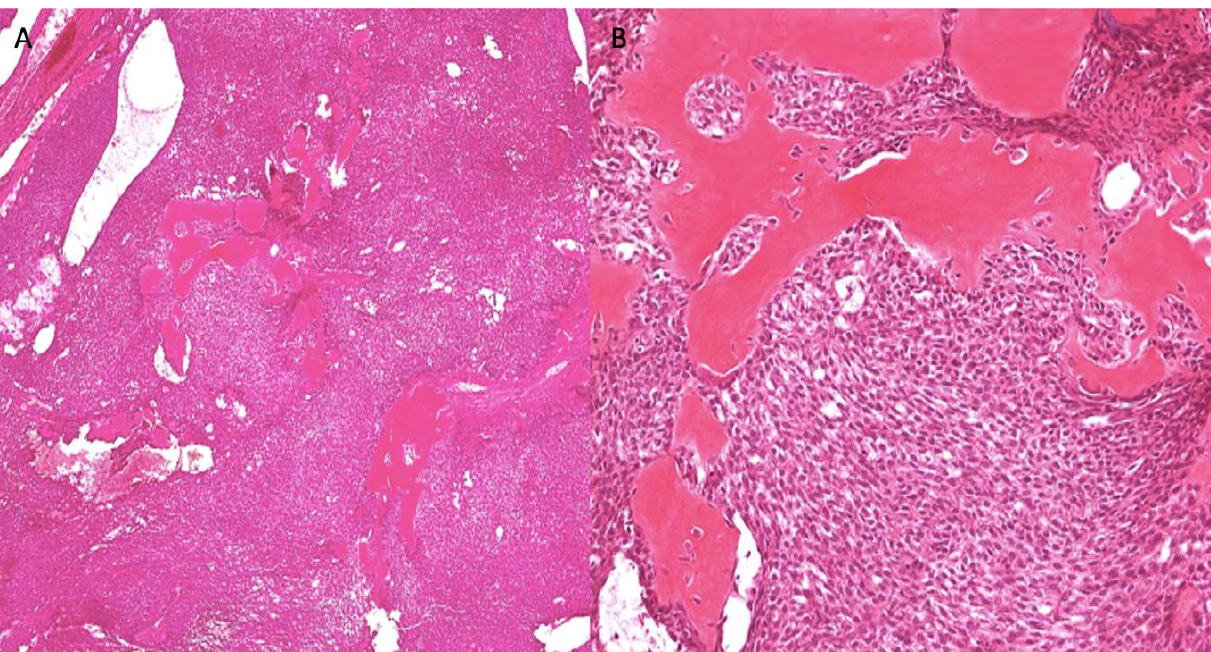
Figure 9. H&E, Infiltrative odontogenic epithelial neoplasm intermixed with eosinophilic dentinoid matrix. Neoplastic proliferation surrounded by reactive cellular osseous trabeculae with osteoblastic rimming (100× ( A ) and 200× ( B )).